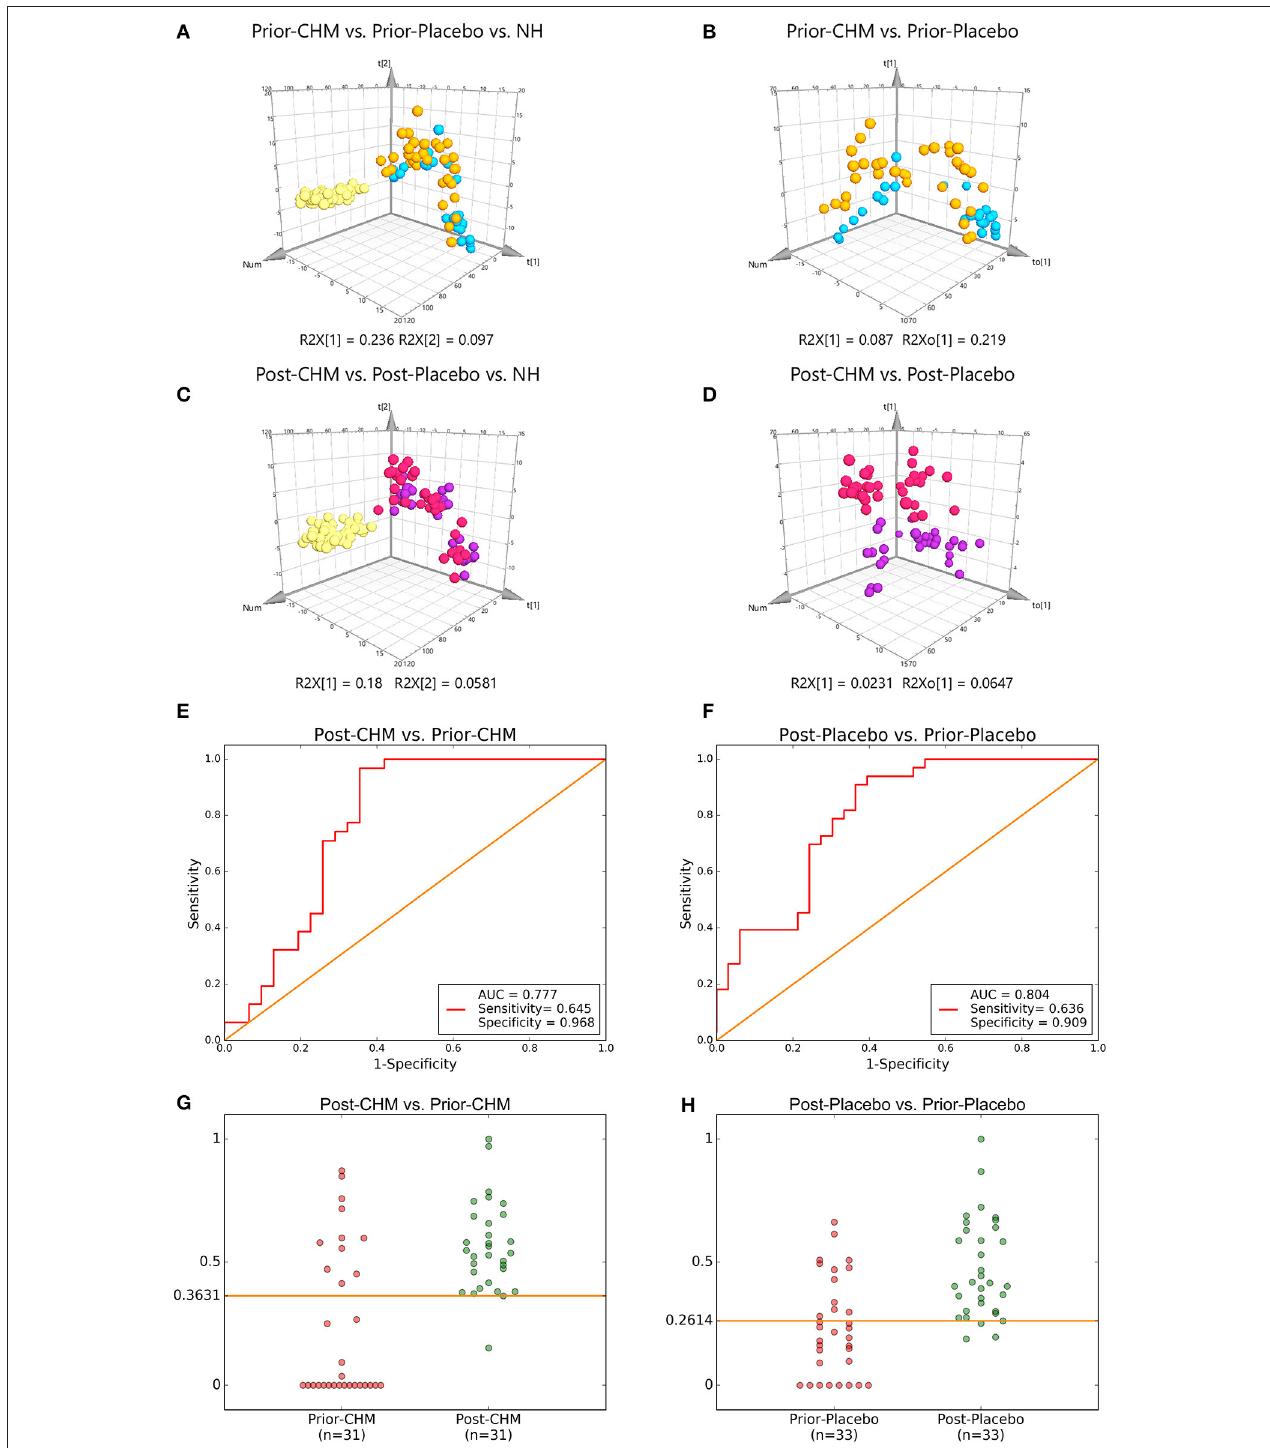
FIGURE 6 | PLS-DA & OPLS-DA Score Plots and Treatment & five-fold Cross Validation Outcomes. PLS-DA Score Plots compared (A) Prior-CHM vs. Prior-Placebo vs. NH, (C) Post-CHM vs. Post-Placebo vs. NH. OPLS-DA Score Plots compared (B) Prior-CHM vs. Prior-Placebo, (D) Post-CHM vs. Post-Placebo. The treatment outcomes are shown via the receiver-operating characteristic (ROC) curves for comparison between (E) Post-CHM vs. Prior-CHM, (F) Post-Placebo vs. Prior- Placebo. The five-fold Cross Validation Outcomes were for (G) Post-CHM vs. Prior-CHM, (H) Post-Placebo vs. Prior-Placebo. AUC, Area Under the Curve; CHM, Chinese herbal medicine; NH, Normal healthy group. Green, NH; Yellow, Prior-Placebo; Blue, Prior-CHM; Red, Post-Placebo; Purple, Post-CHM.